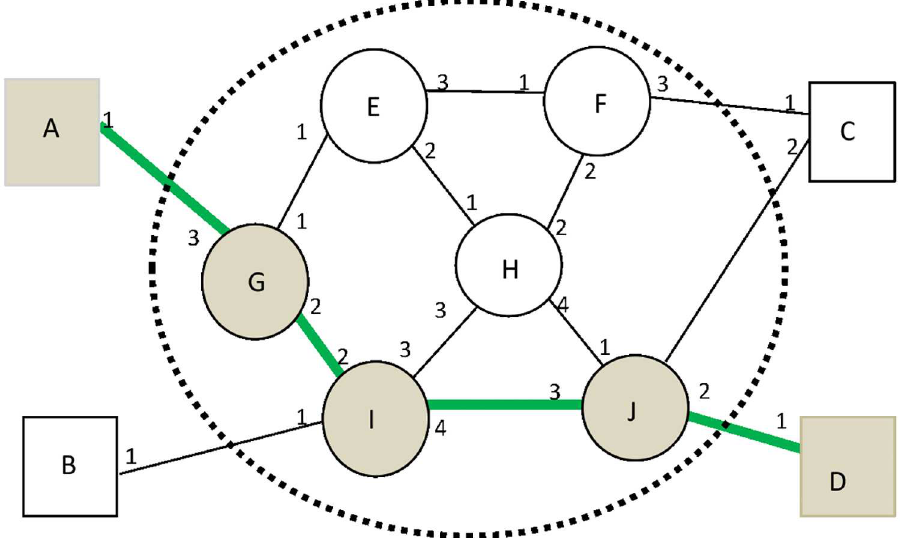
Fig 2. VA and the assignment of PI. Assuming the communication path from A to D is A- > G- > I.- > J- >